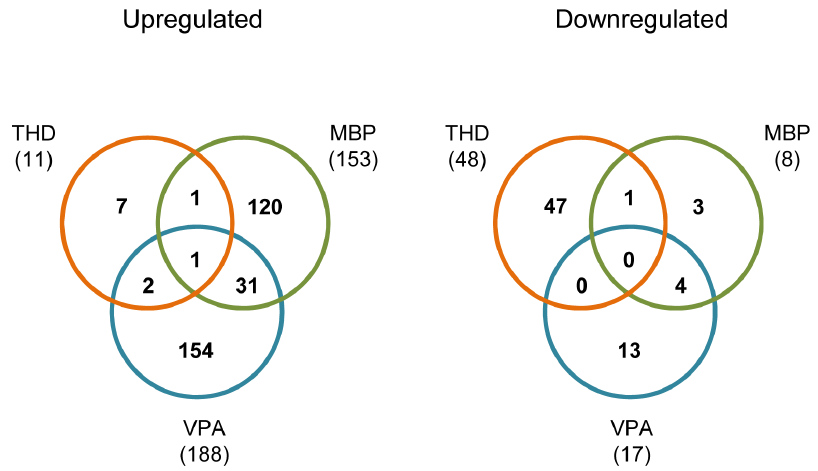
Figure 9. Venn diagrams showing overlap of DEGs induced by different compounds. The total number of upregulated or downregulated DEGs induced by each compound is included in the parentheses under the time. THD, thalidomide; MBP, monobutyl phthalate; VPA, valproic acid.